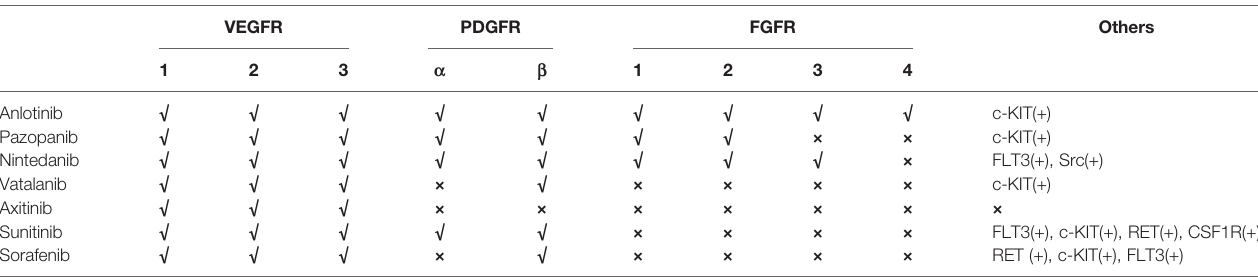
TABLE 1 | The different targets between anlotinib and other RTK. inhibitors.